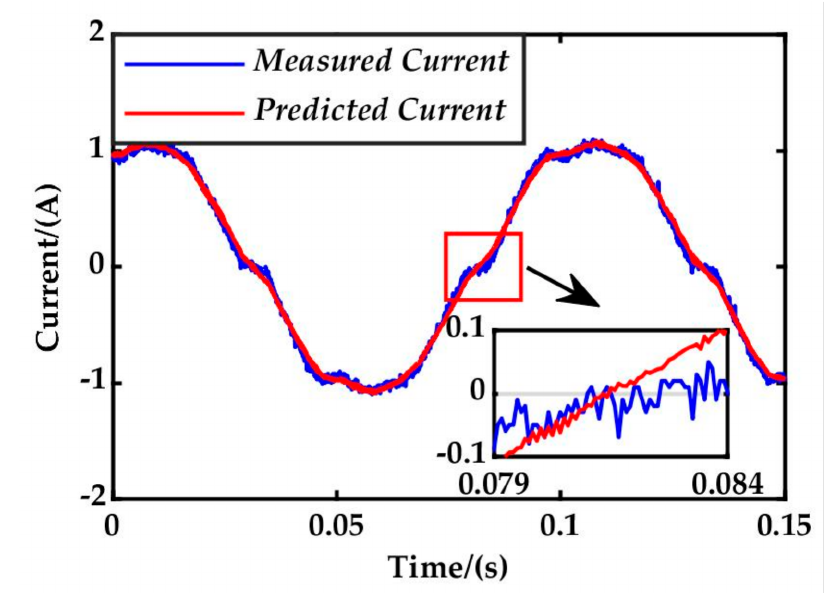
Figure 5. Measured and predicted phase